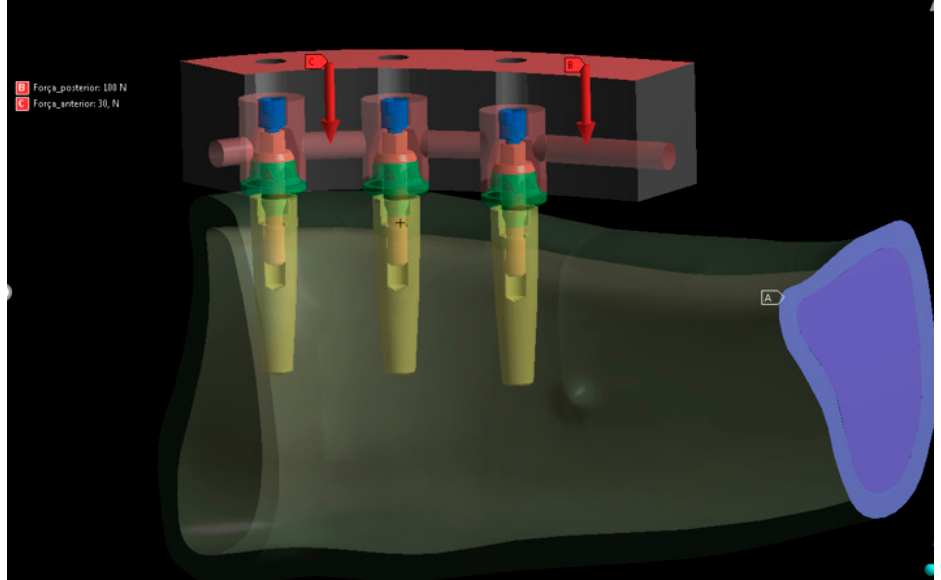
Figure 3. Loading Figure 3. Loading configuration.